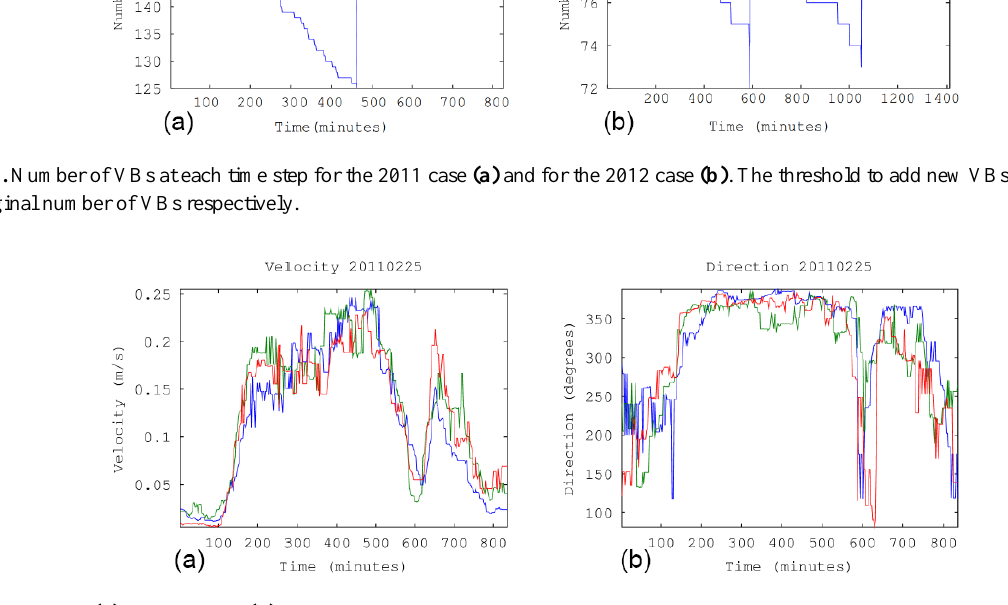
Figure 11. Velocity (a) and direction (b) for the 2011 case selected three VBs. The direction is in